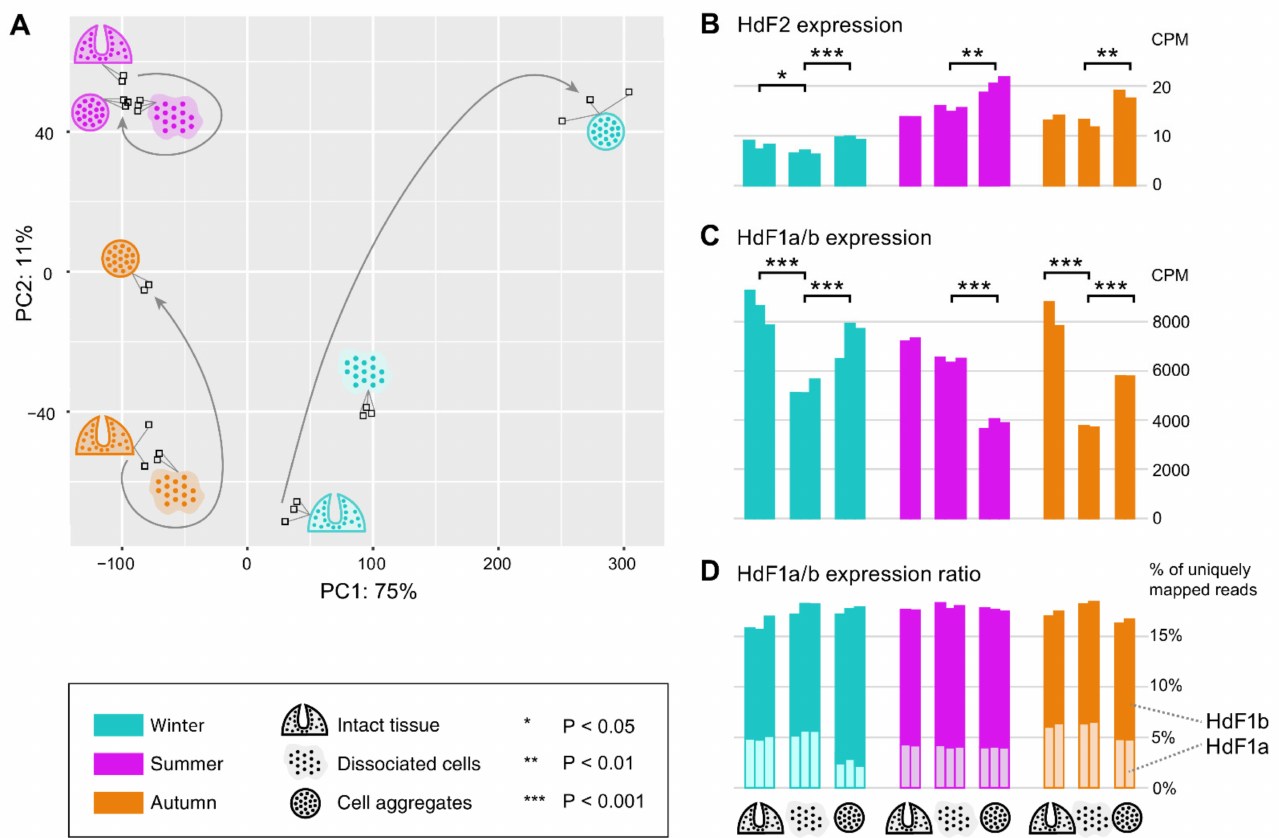
Figure 10. Expression of ferritin genes during the dissociation/reaggregation processes in sponge H. dujardini during the different periods of the annual cycle. ( A ) Principal component analysis (PCA) plot of RNA-Seq samples colored by the life cycle stages (Winter, cyan; Summer, purple; Autumn, orange) and marked by the pictograms of the stages of the dissociation/reaggregation experiment. ( B , C ) Ferritin HdF2 and HdF1a/b transcript expression in CPM (calculated by edgeR after normalization), each bar represents one replicate. Statistical significance is shown for BH-adjusted p -values of the t-test carried out for replicates of each period. Since the HdF1a and HdF1b copies are nearly identical, their expression is shown in total (reads were mapped to one transcript). ( D ) Stacked barplot showing the percentage of the reads mapped uniquely to HdF1a (light boxes) or HdF1b (dark boxes) gene copy, out of the total number of reads mapped to these copies, that could be used as an estimate for the transcriptional ratio between two